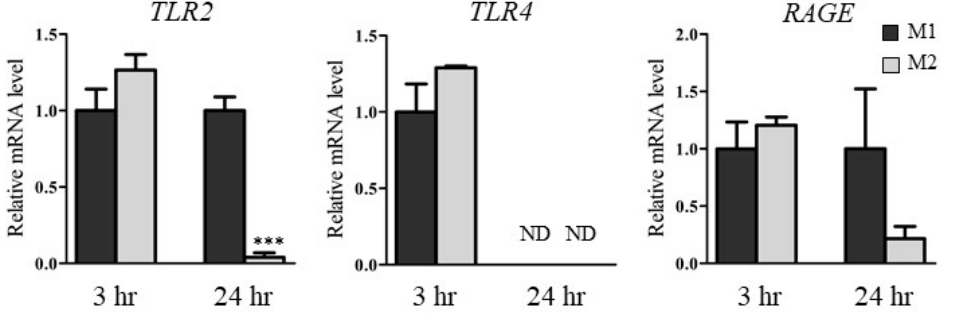
Figure 6. Relative mRNA levels of TLR2 , TLR4 , and RAGE in M1 and M2 3 h or 24 h after DIC treatment (500 µ M) to HepG2, HepG2/M1, and HepG2/M2. The results are expressed as the mean ± SE of each group (n = 3–4). ND indicates not detected. Significant difference (*** p < 0.001 vs. M1 of 24 h) was observed. Table 1. HMGB1 concentrations in the medium of HepG2, HepG2/M1, and HepG2/M2 3 h or 24 h after DIC treatment (500 μ M).